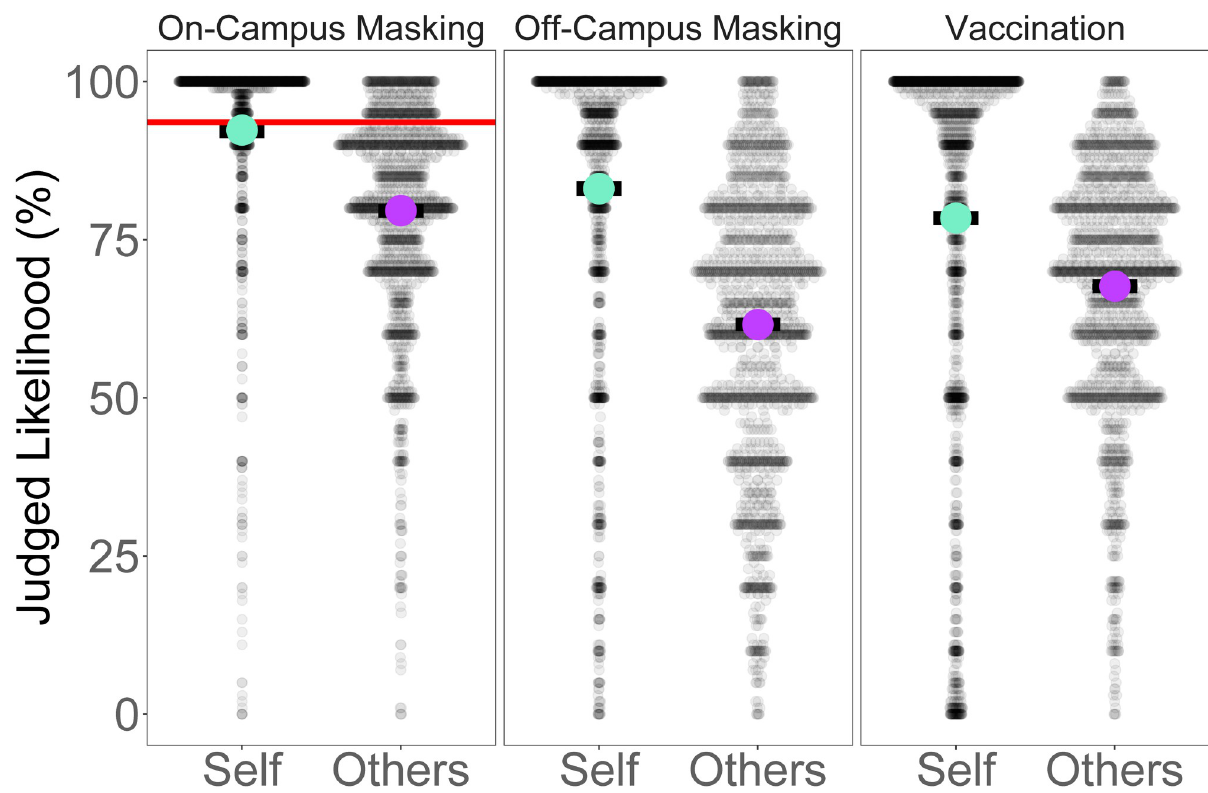
Fig 1. Self-Reported intent and estimates of others’ intent per outcome. Semi-transparent dots represent individual participant estimations for each category, with more opaque dots representing estimates endorsed by more participants. The larger (colored) dots represent the posterior distribution means for each outcome, while the black bars represent the 95% credible intervals around these